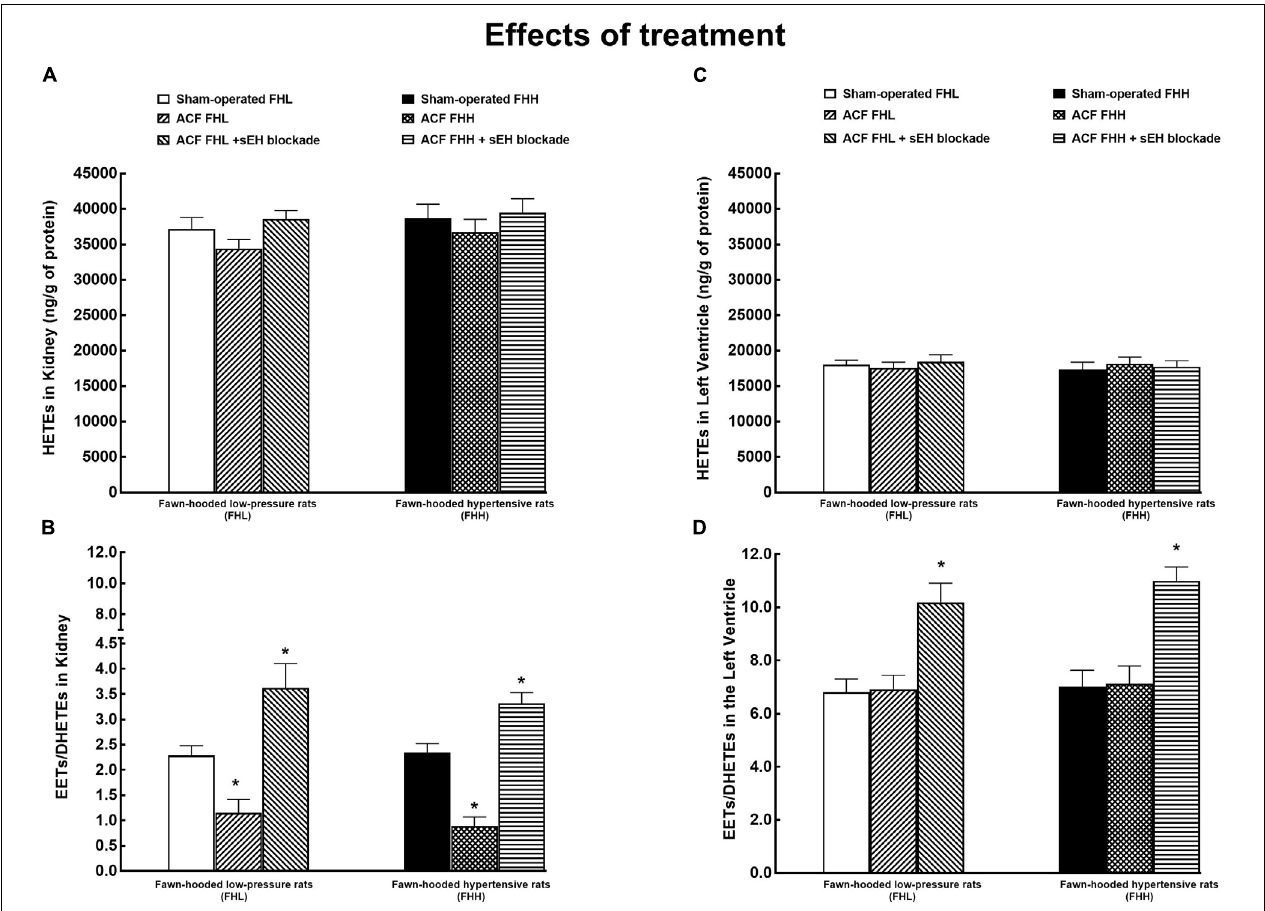
FIGURE 7 | Renal tissue concentrations of hydroxyeicosatrienoic acids (HETEs) (A) , the renal ratio of epoxyeicosatrienoic acids (EETs) to dihydroxyeicosatrienoic acids (DHETEs) (B) , HETE concentrations in the left ventricle (C) , and EETs/DHETEs ratio in the left ventricle (D) in the sham-operated FHL rats with ACF and ACF FHL rats treated with the sEH inhibitor, and in sham-operated fawn-hooded hypertensive (FHH) rats, and in untreated or sEH-treated ACF FHH rats. ∗ P < 0.05 compared with the sham-operated